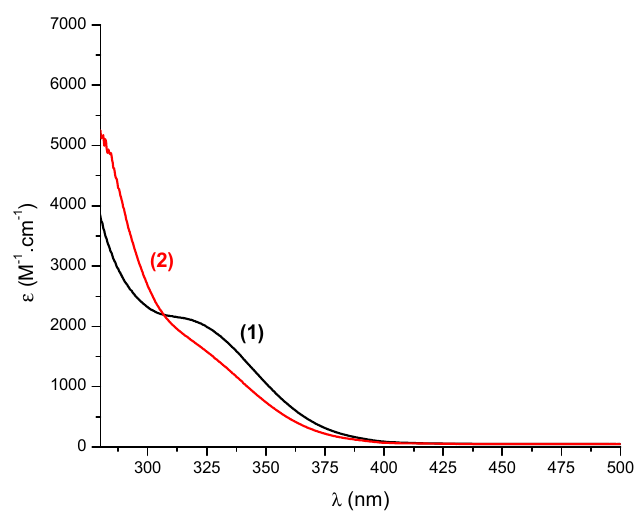
Figure 5. UV-visible spectra of (1) S5 and (2) S6 in acetonitrile.